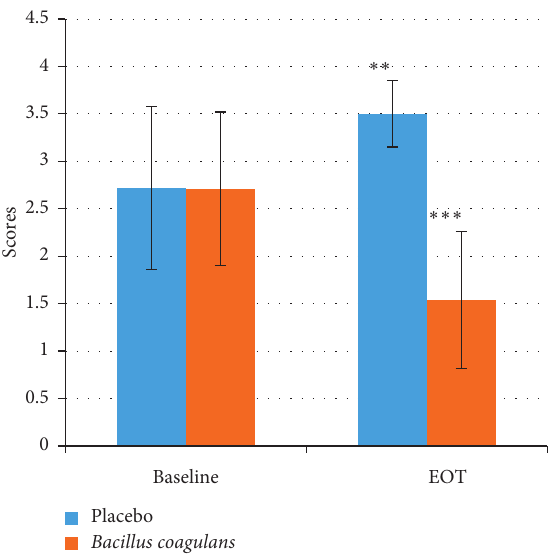
Figure 5: Plaque lactobacillus scores at baseline and EOT. Values